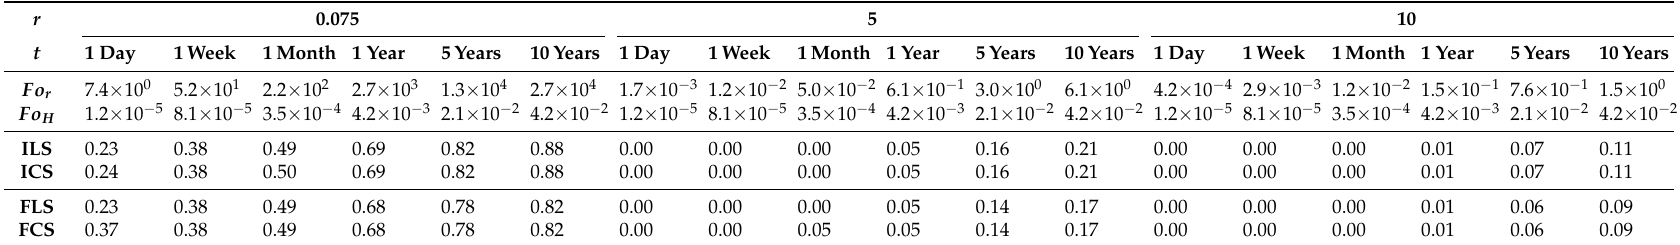
Table 4. Configuration #2: comparison among the Θ g values evaluated through different analytical models. r b = 0.075 m, H b = 60 m, R (cid:48) =